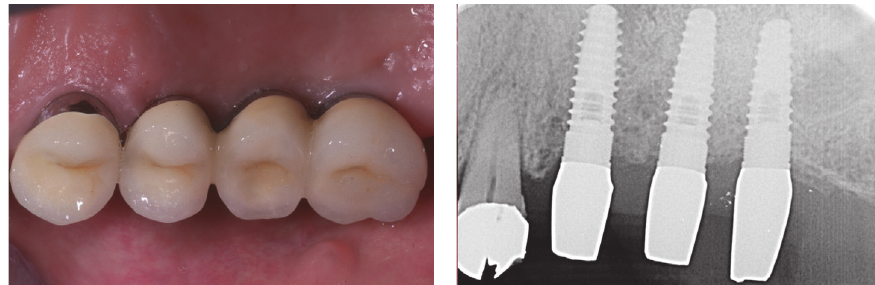
Figure 11: The final prosthetic rehabilitation.